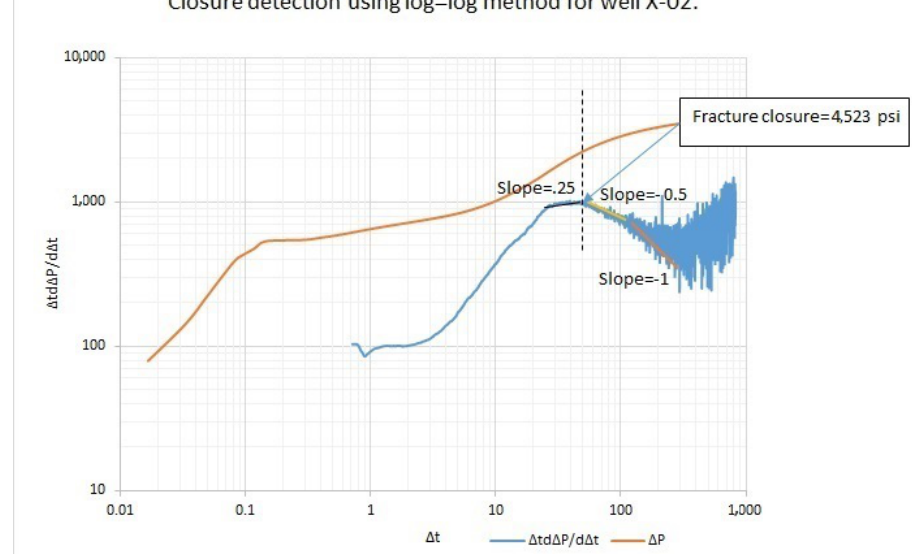
Figure 30. Closure detection using the log–log analysis technique for well X-02 (closure identified when the slope of changes from 1/4 (pre-closure bilinear flow) to − 1/2 (post-closure formation linear)). Table 4. Fracture closure pressure for well